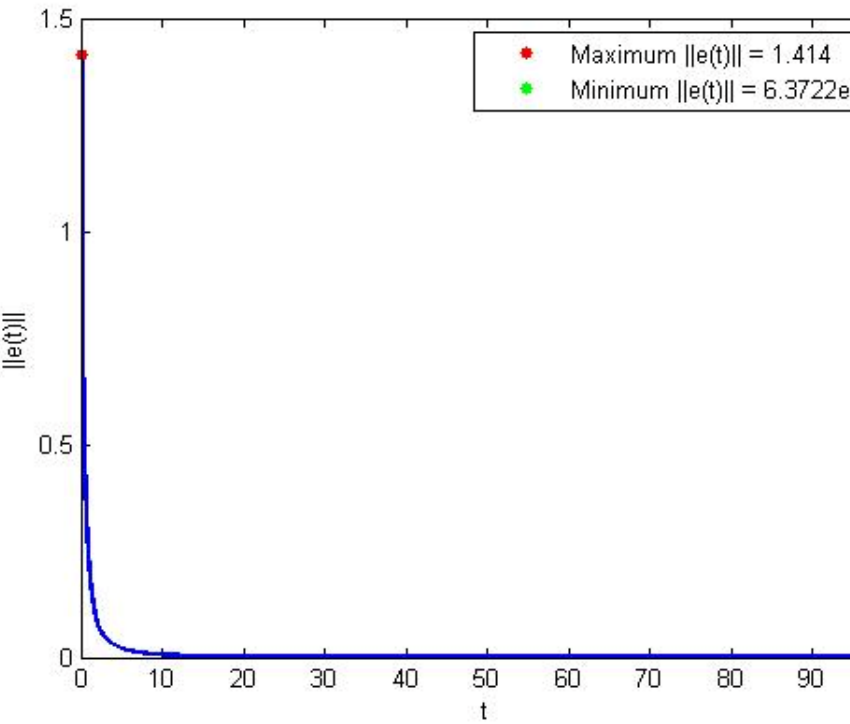
(cid:2) (cid:3) T 1 e − t .